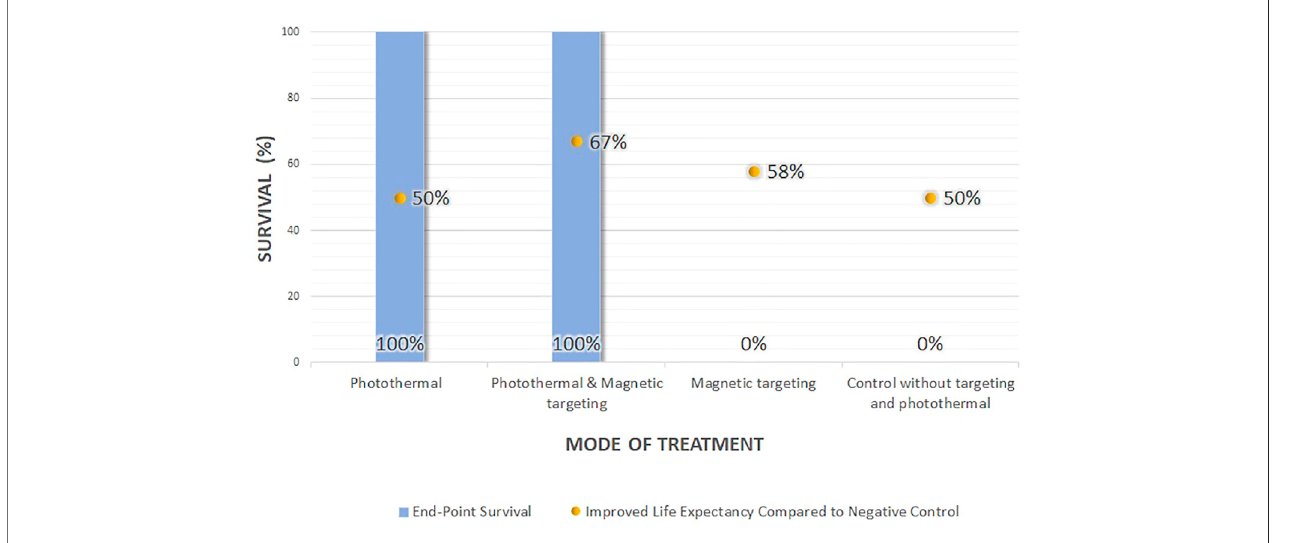
FIGURE 2 | The effect of treatment method on the survival rate of rodents.